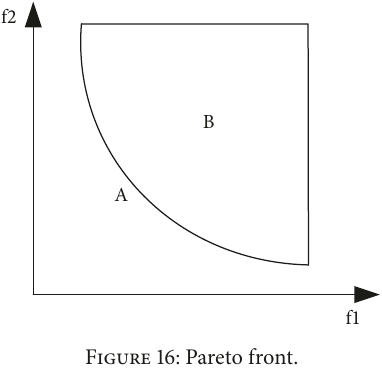
Figure 16: Pareto